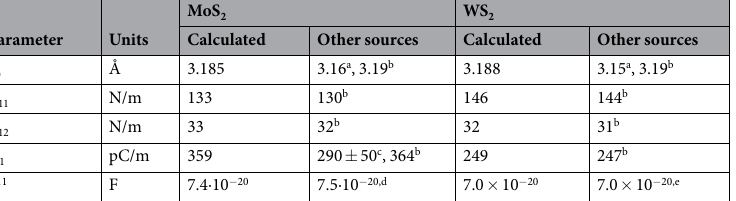
Table 1. Structural parameters and effective 2D elastic, piezoelectric and static dielectric properties of single-layer hexagonal MoS 2 and WS 2 from self-consistent DFT calculations (relaxed-ion approximation). (1) Experimental 36 . (2) Calculated with DFT/GGA 10 . (3) Experimental 12 . (4) Obtained using Eq. (6) based on MoS 2 bulk in-plane relative dielectric permittivity of 15 and the interlayer separation of 6.02 Å 37 . (5) Obtained using Eq. (6) based on WS 2 bulk in-plane relative dielectric permittivity of 14 and the interlayer separation of 6.06 Å 37 .